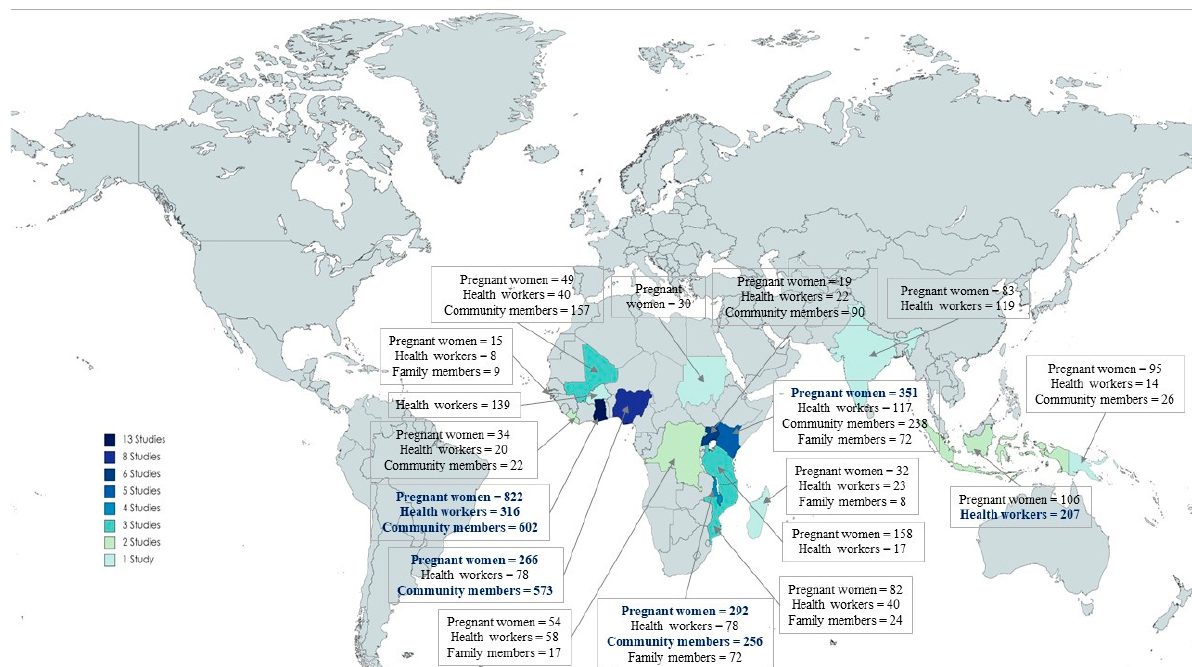
Figure 2. Number of studies according to country and investigated populations.